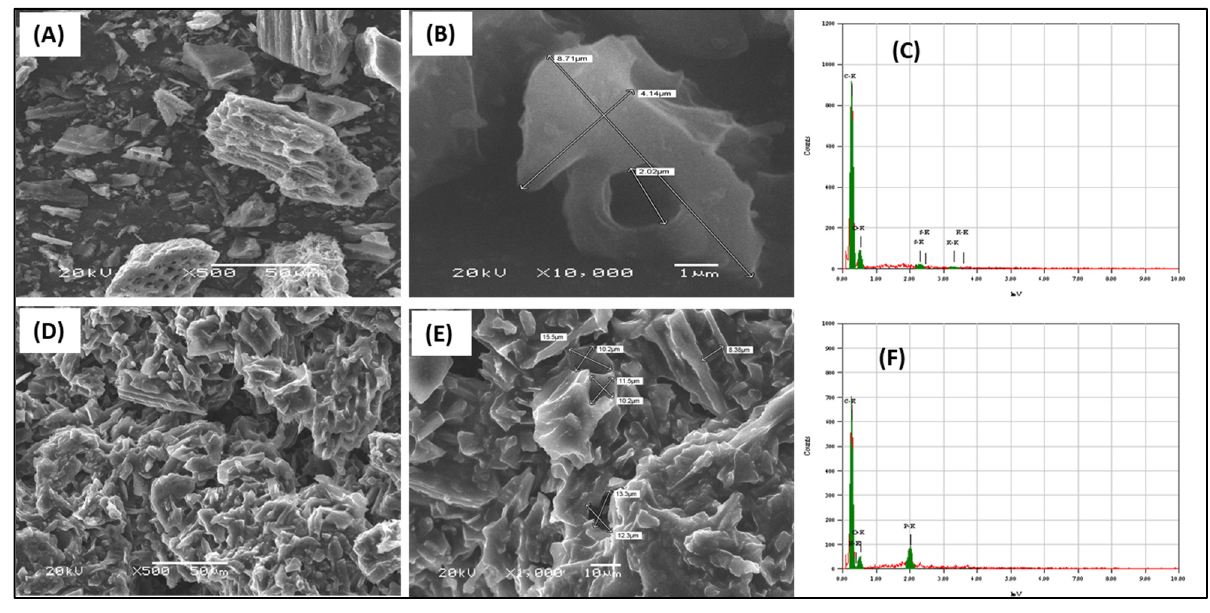
Figure 3. SEM images of carbon ( A , B ) and trihexYl(tetradecyl)phosphonium dicyanamide-modified renewable carbon ( D , E ) and the EDS of carbon ( C ) and trihexYl(tetradecyl)phosphonium dicyana- mide-modified renewable carbon ( F